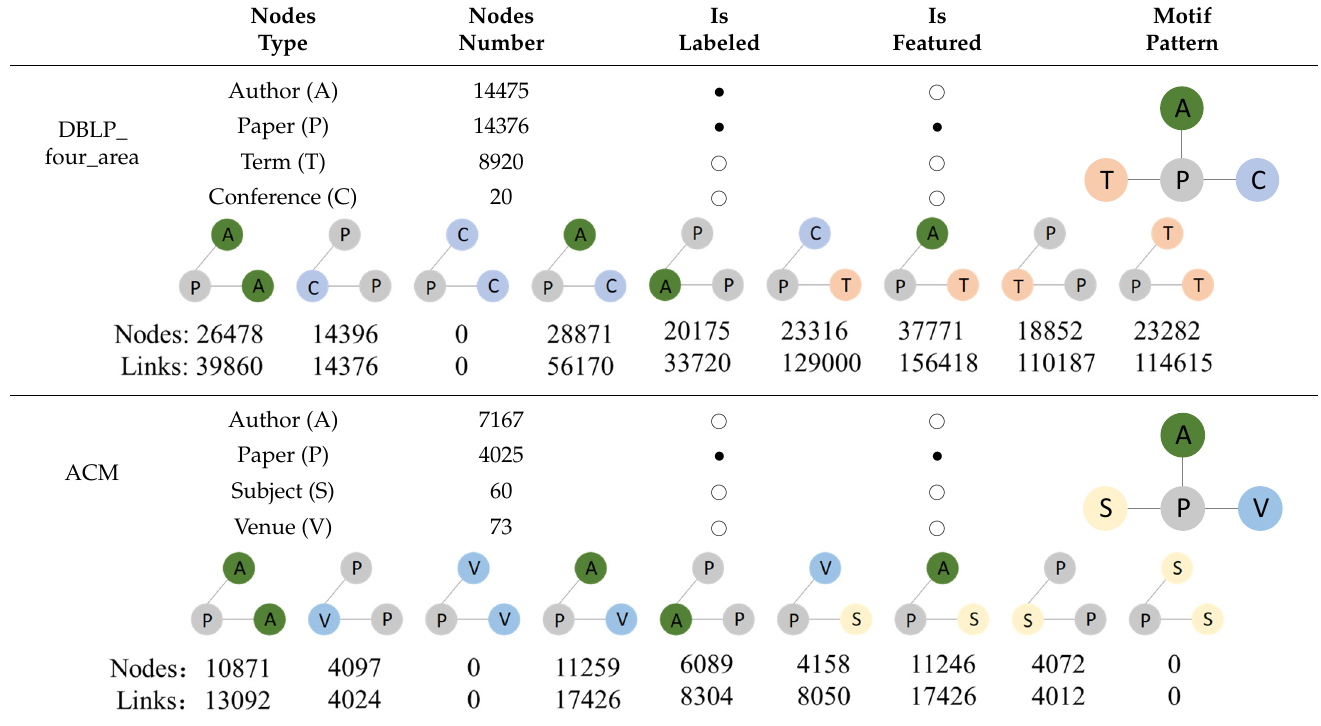
Table 2. Details of the datasets used in the MBHAN evaluation experiments.